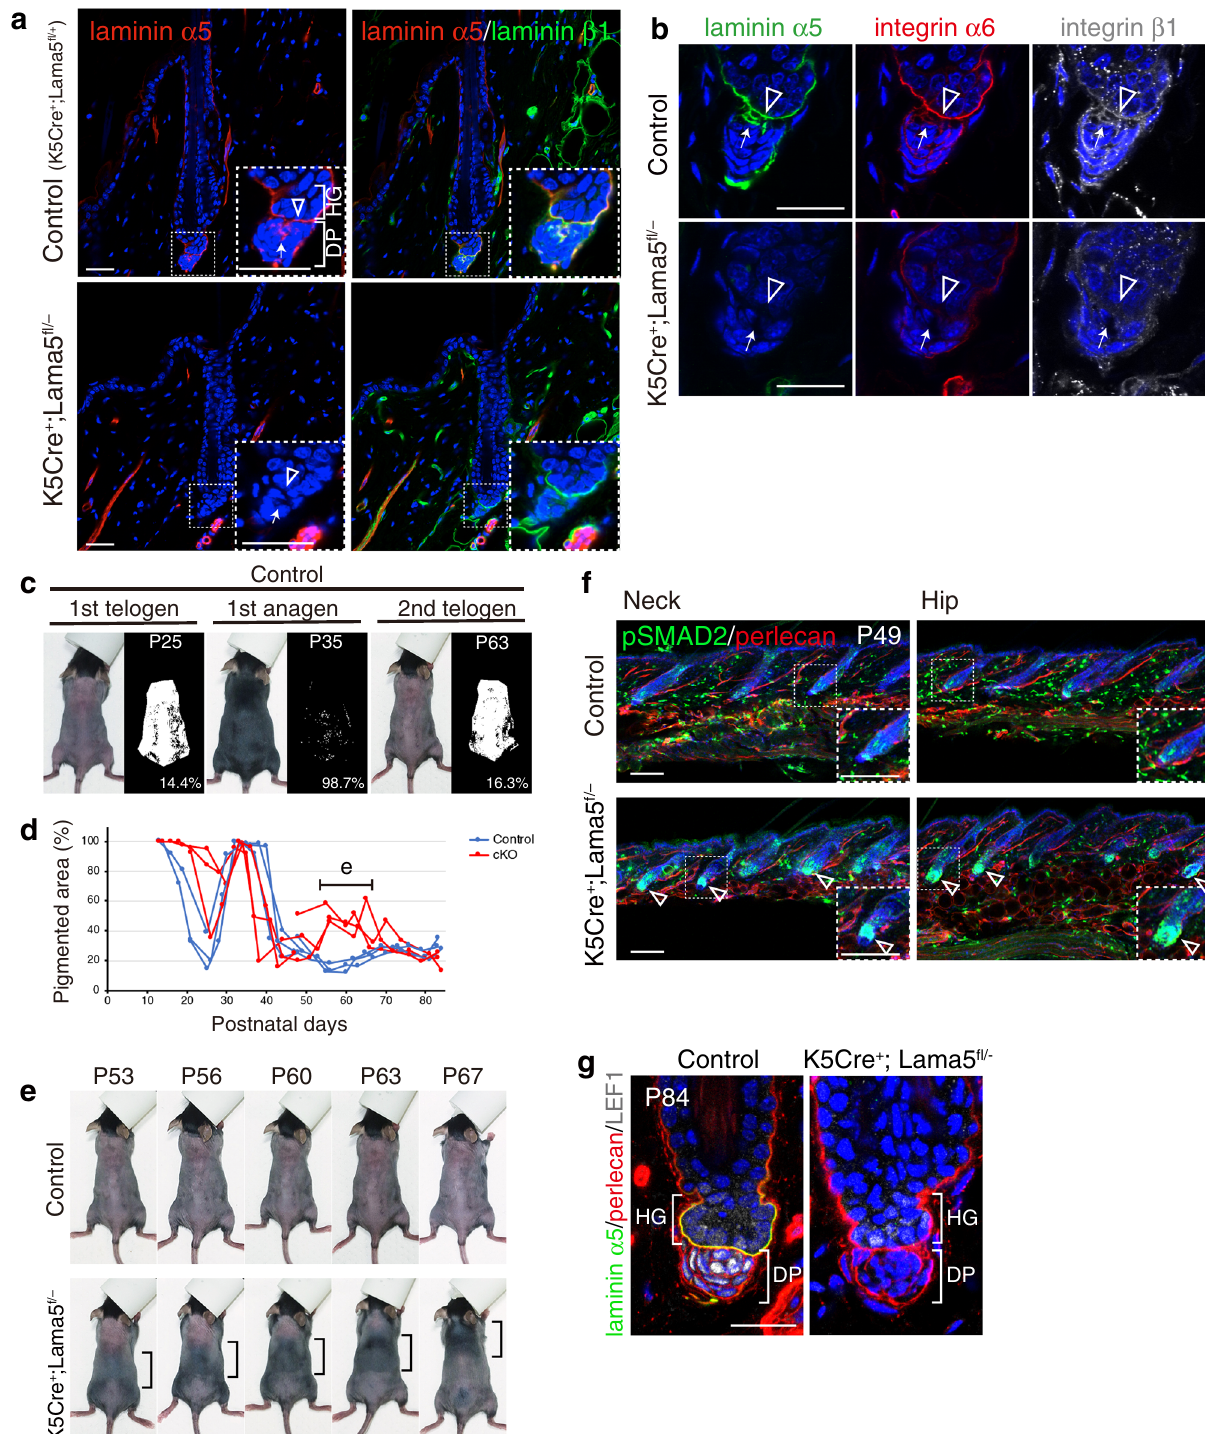
collagenase type I at 37°C for 2 h with gentle mixing. Single-cell suspension was obtained by repeated gentle pipetting and passed through a 40 μ m cell strainer (Falcon, NC, USA). To eliminate Lin + cells, the cell suspension was stained with the antibody cocktail used in the epithelial cell preparation. To further distinguish the target cell populations from the remaining epithelial cells, the expression of CD49f was examined using a PE-conjugated antibody. For the further analysis of dermal cell populations, the cell suspension was also stained with CD34-eFluor660 antibody. Cell isolation procedures are shown in Supplementary Fig. 1a – g. To determine the DP cell population, mRNA expression levels of Pdgfra , Itga8 and eGFP were examined by qRT-PCR (Supplementary Fig. 1k, l). Cells were sorted with a FACSAria II according to the expression of reporter eGFP and cell